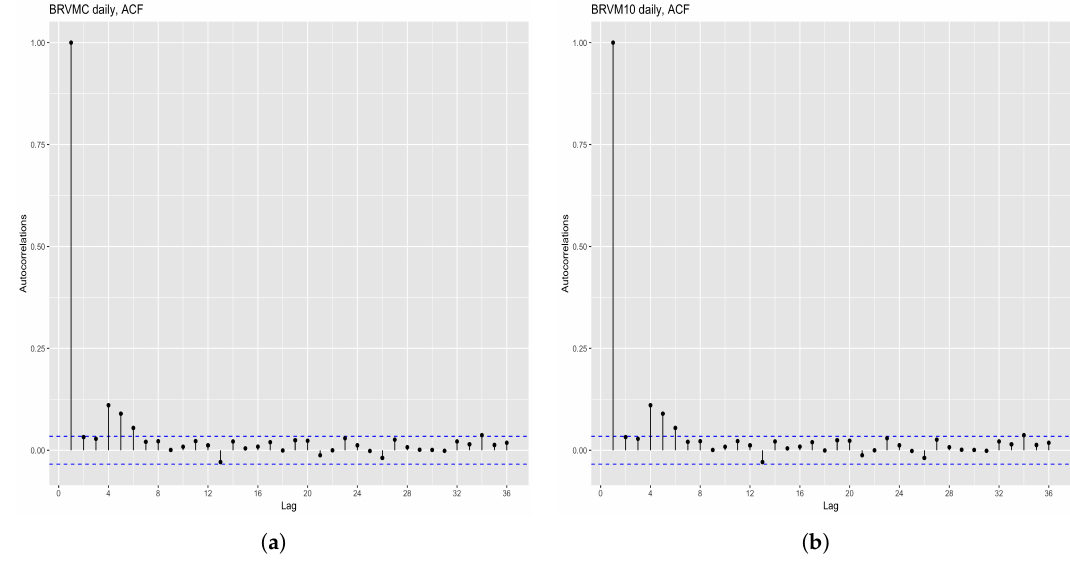
Figure A3. Correlogram of the BRVMC and BRVM10 returns. ( a ) Correlogram of the BRVMC; ( b ) Correlogram of the